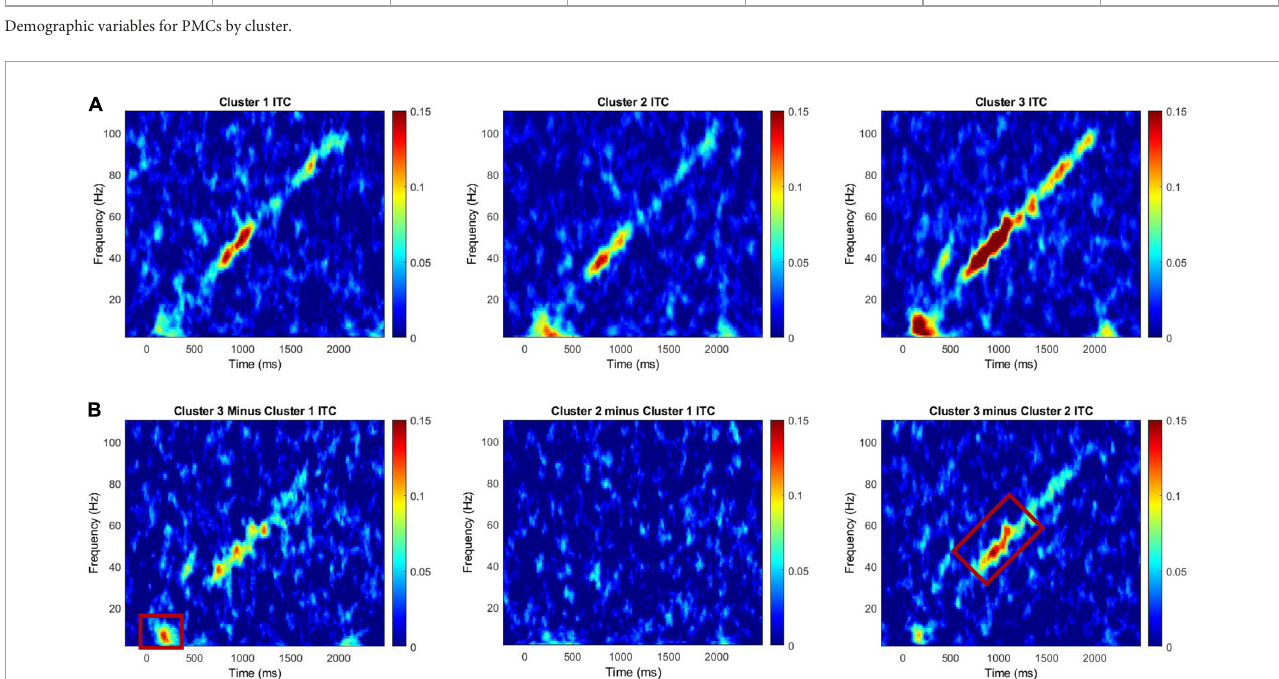
FIGURE1 (A) Intertrial coherence for Clusters 1, 2, and 3 for the chirp task. (B) Difference plots for cluster 3 minus cluster 1, cluster 2 minus cluster 1, and cluster 3 minus cluster 2. Red boxes on difference maps indicate areas with significant group differences. Warmer colors in difference maps indicate higher phase-locking values for the first cluster and the cooler colors indicate higher values for the second